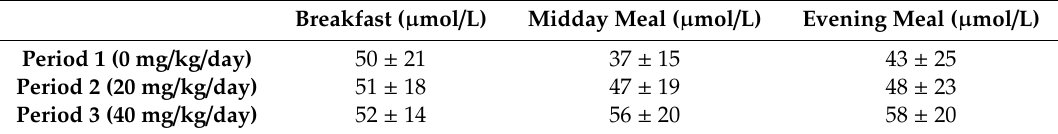
Table 3. Descriptive information about mean blood phenylalanine concentrations at different sample moments during the different study periods, presented with mean ± standard deviation (SD).